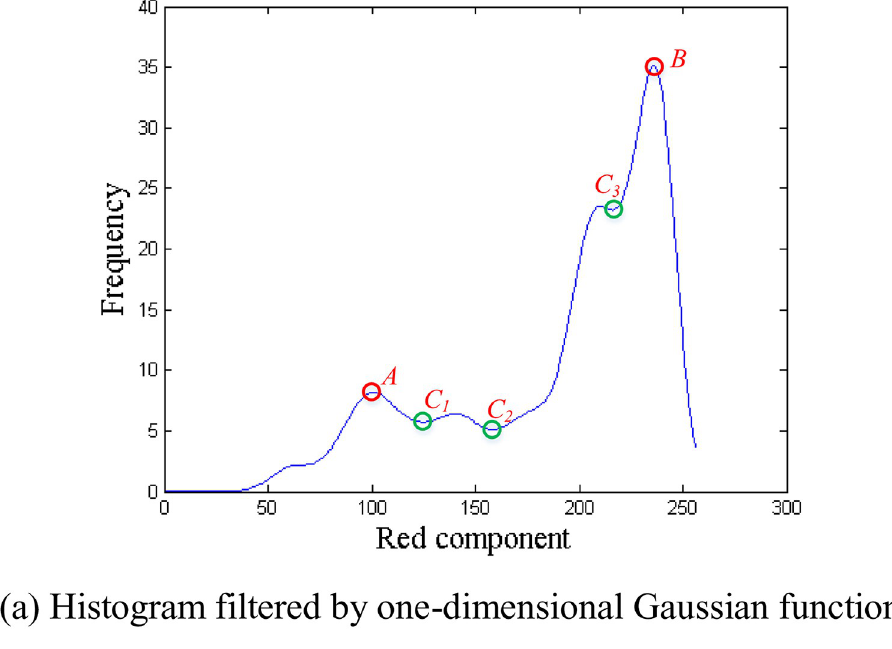
Fig 5. An example of a